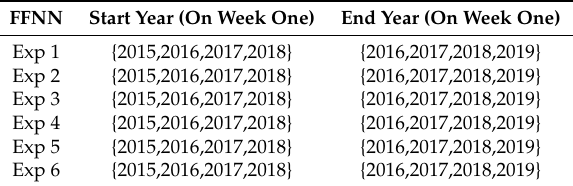
Table 4. Testing sets. Each test consisted of twelve experiments, six with retraining and six without retraining the network.